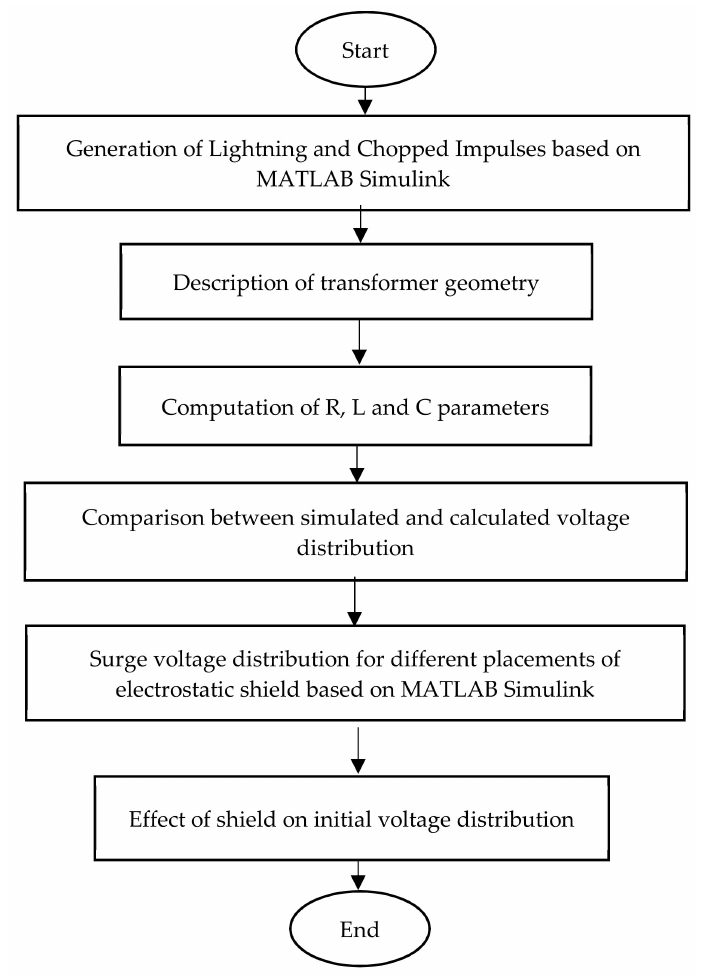
Figure 2. Framework to examine the e ff ect of shield on the surge voltage distribution in the HV